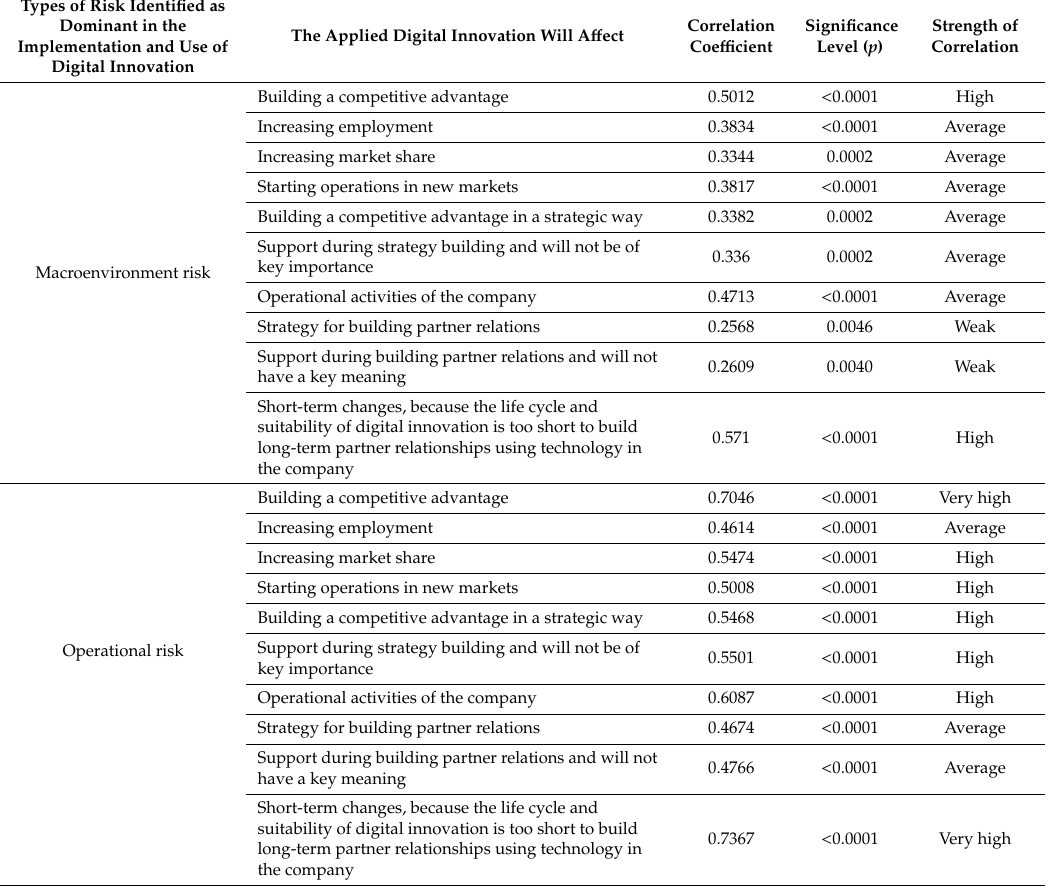
Table 6. E ff ect of implementation of digital technology on